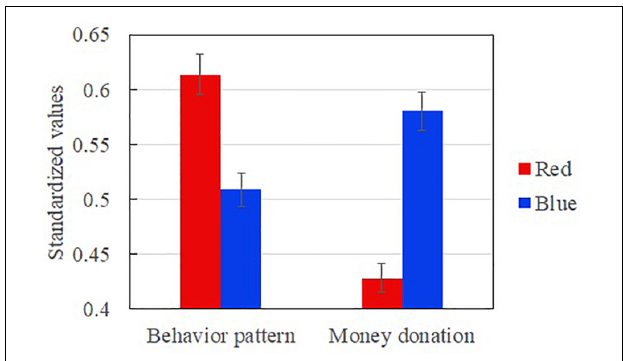
FIGURE 2 | Behavioral patterns and monetary donations as a function of color.